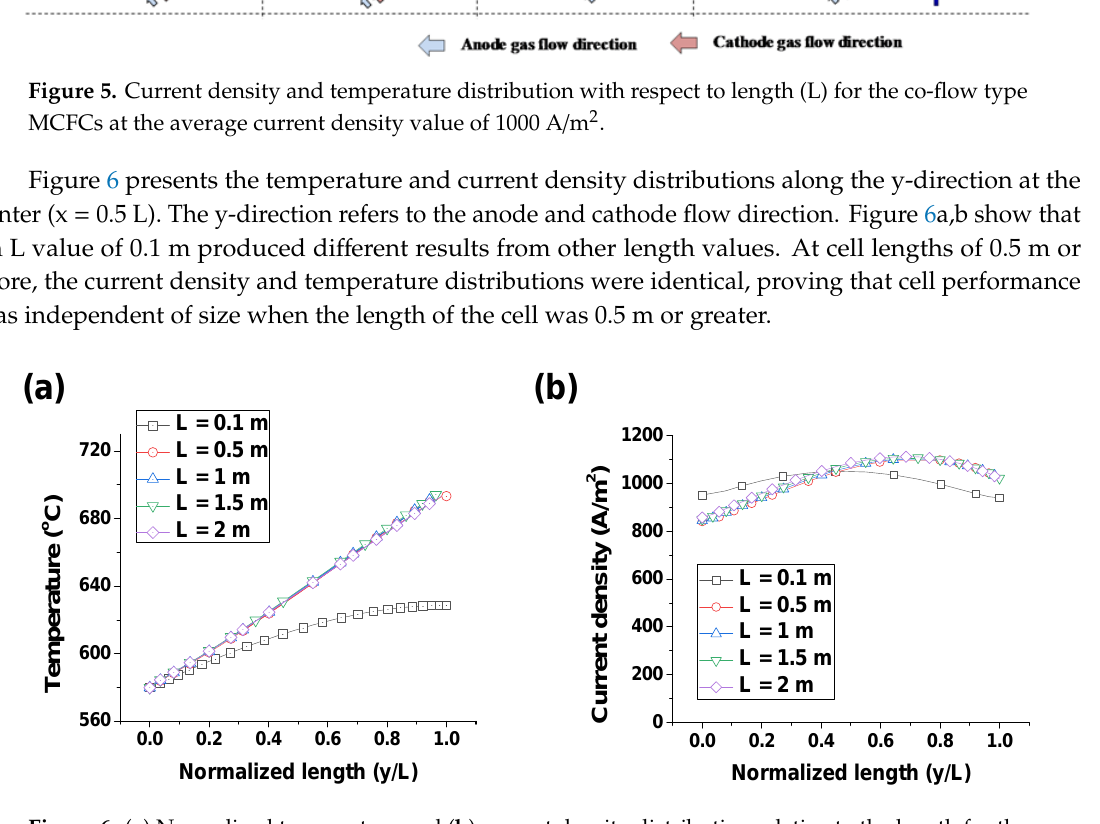
Figure 6. ( a ) Normalized temperature and ( b ) current density distribution relative to the length for the co-flow